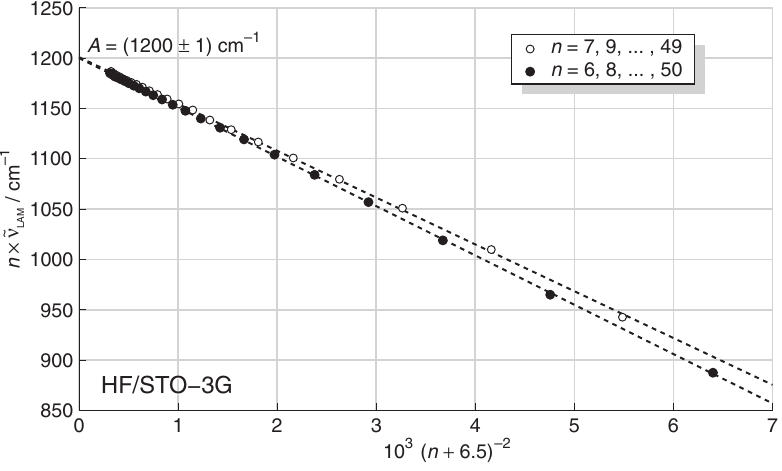
Figure 3. Extrapolation of deperturbed harmonic HF/STO-3G LAM-1 wavenumbers (Gaussian 03 [23]) to in fi nite chain length ( n ).